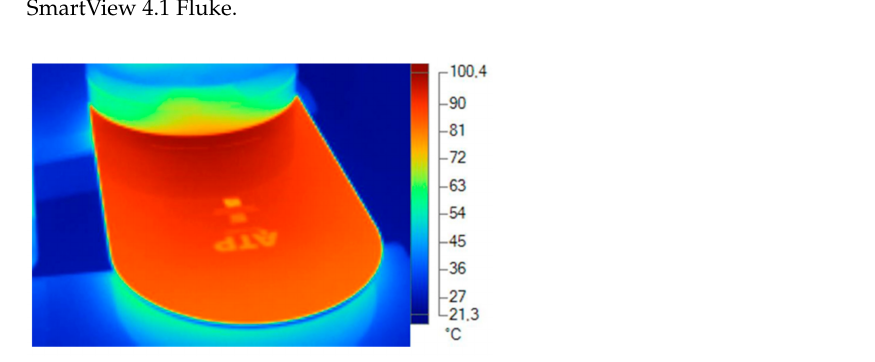
Figure 19. Thermal data of the cover. Blue and green area. Plastic emissivity 0.92. Source: Software SmartView 4.1 Fluke.